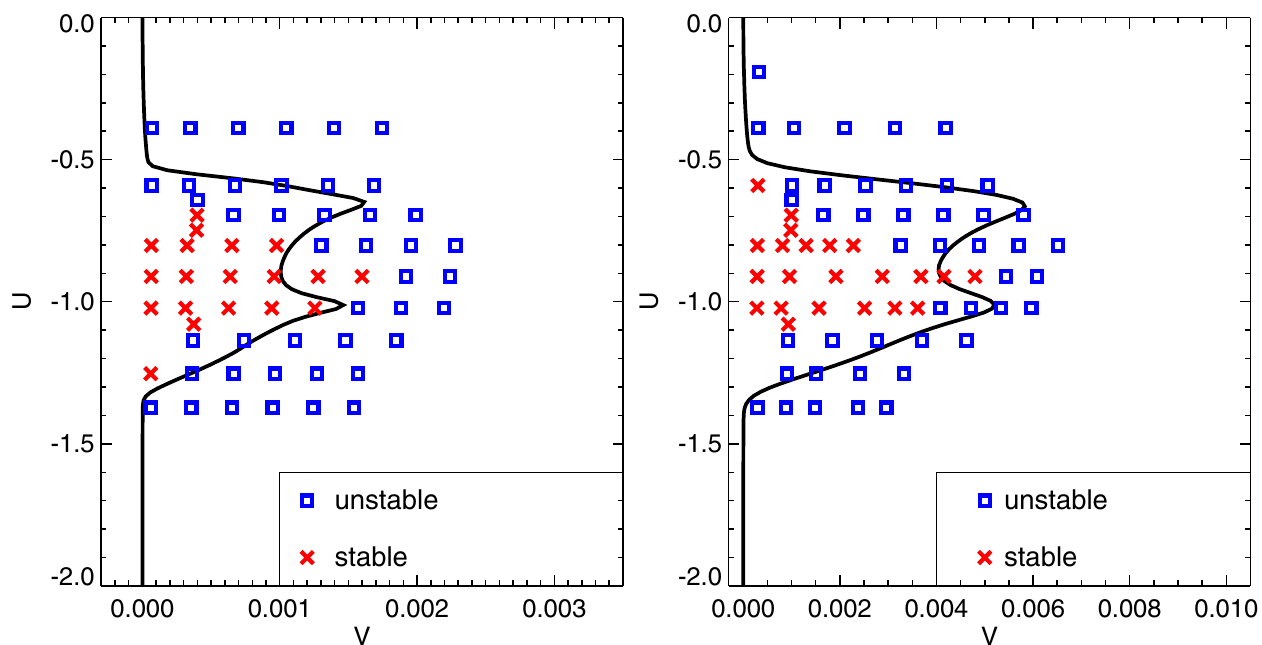
FIG. 9. (Color) Combination of chromatic effects and nonlinear space-charge; in the right plot the momentum spread is doubled in comparison with the left plot. The symbols are the results of simulation runs; lines are stability boundaries from the dispersion